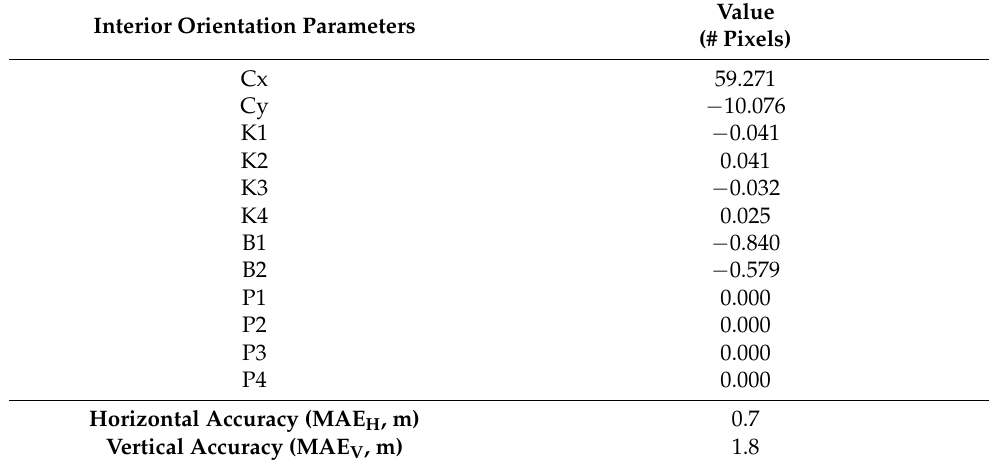
Table 2. Camera internal parameters estimated by Agisoft Metashape. Cx, Cy—principal point coordinates, K1, K2, K3, K4—radial distortion coefficients, P1, P2, P3, P4—tangential distortion coefficients, B1, B2—affinity and non-orthogonality (skew) coefficients. Focal length was fixed at its nominal value (0.05 m). In the last two lines, the table also reports horizontal and vertical accuracy as computed by leave-one-out from GCPs after